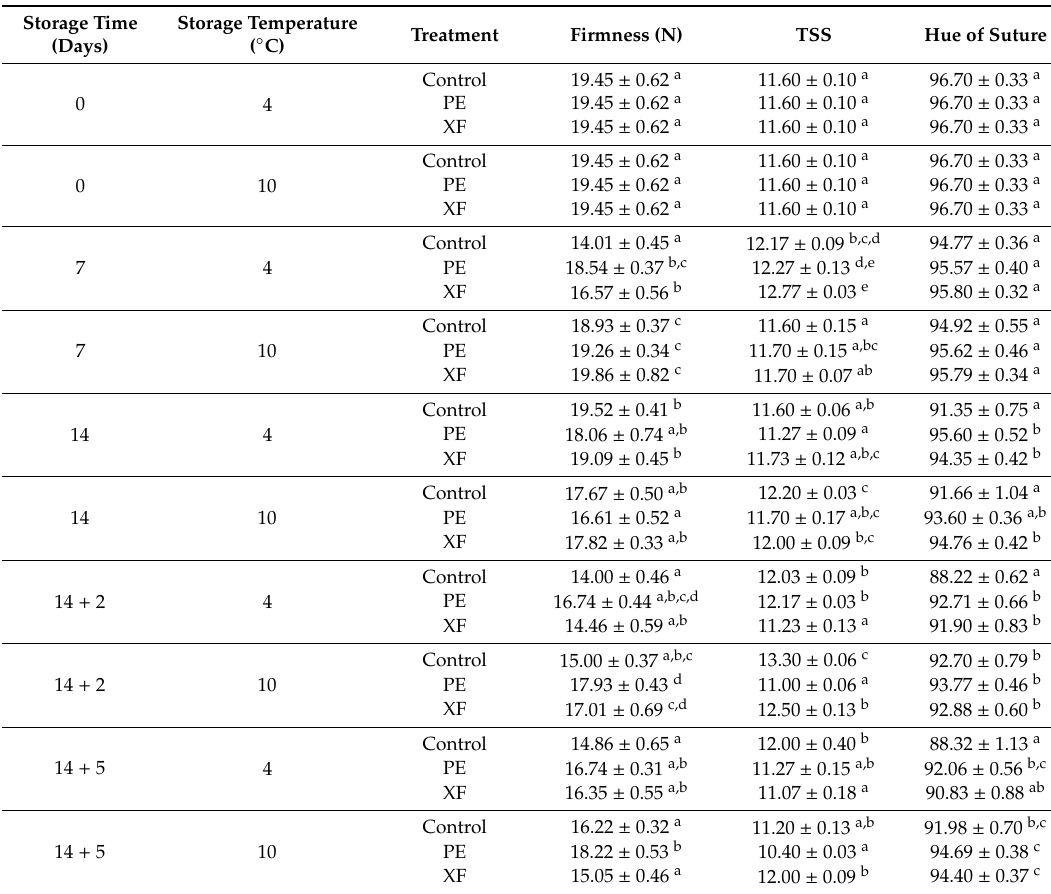
Table 1. Firmness, soluble solid content, and Hue under modified atmosphere film of oriental melon during 4 ◦ C and 10 ◦ C